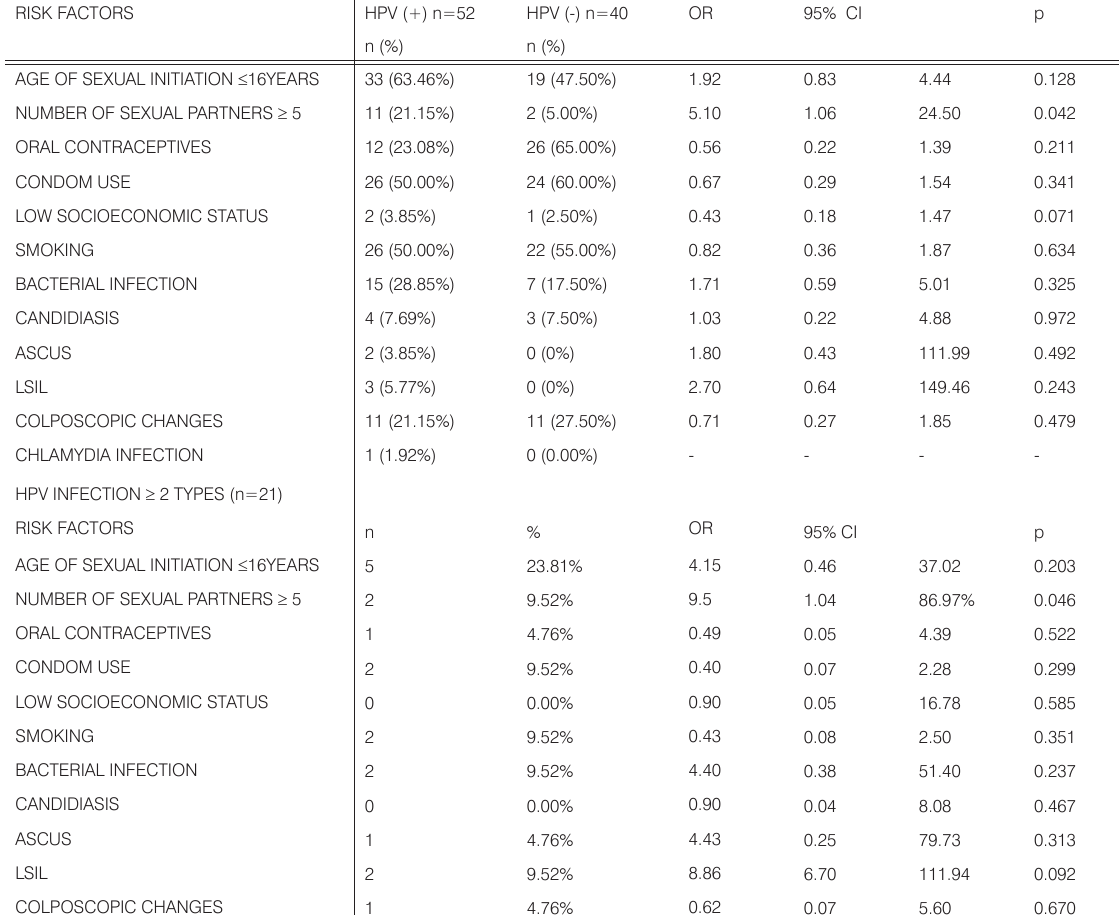
Table 2. The relationship between human papilloma virus infection and the other studied risk factors for cervical